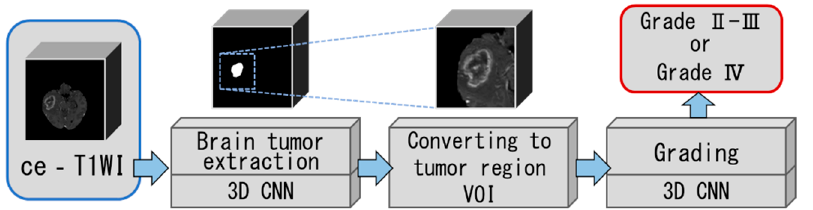
Figure 1. Outline of the proposed method. The processing in the method is fully automated, and there is no manual extraction of the tumor region and creation of VOI.